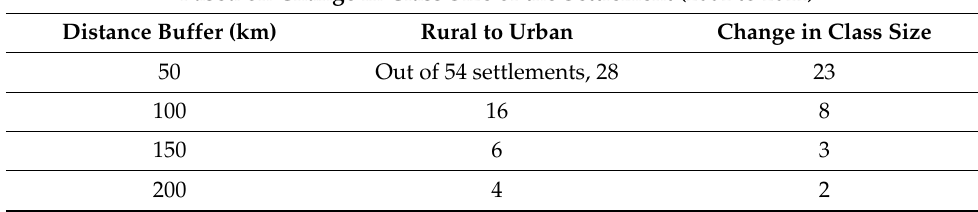
Table 2. Emergence of urban settlements .